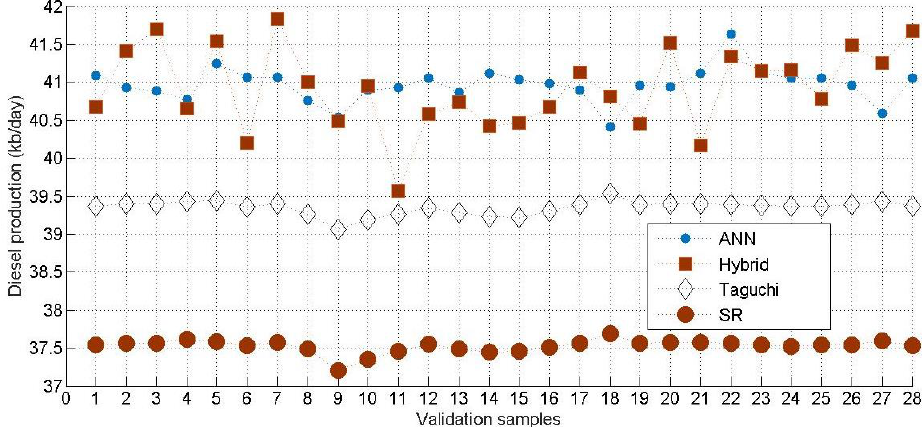
Figure 8. Comparison of diesel production obtained through straight run (SR), Taguchi technique, hybrid framework, and ANN model.